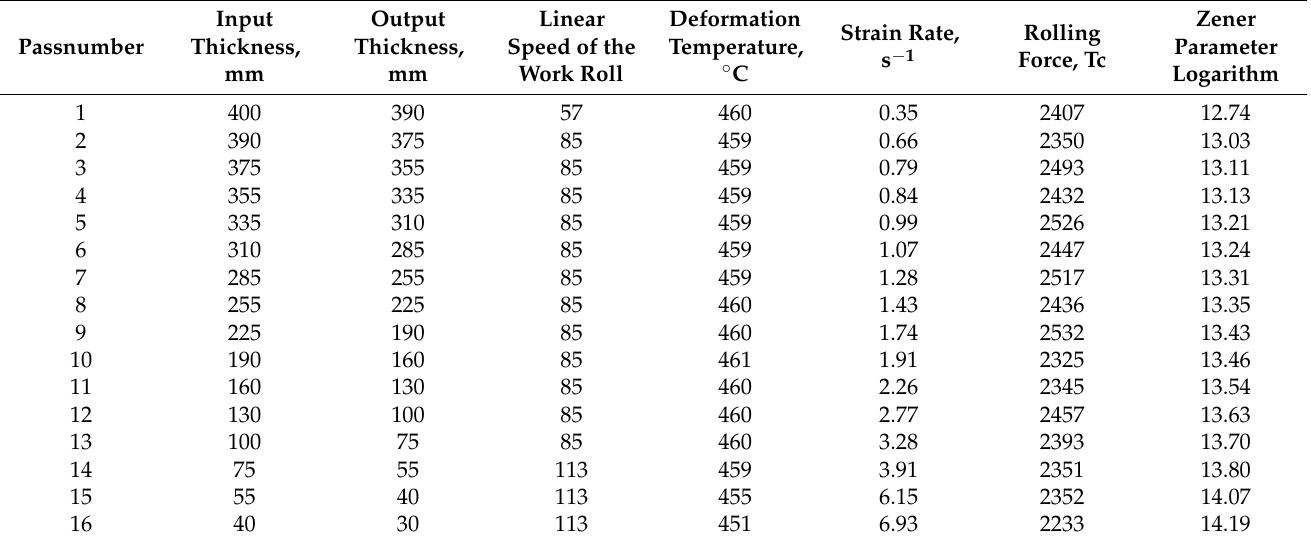
Table 2. Rolling of the AlMg 6 Mn 0.7 (1565 ch) alloy in the hot reversing mill.